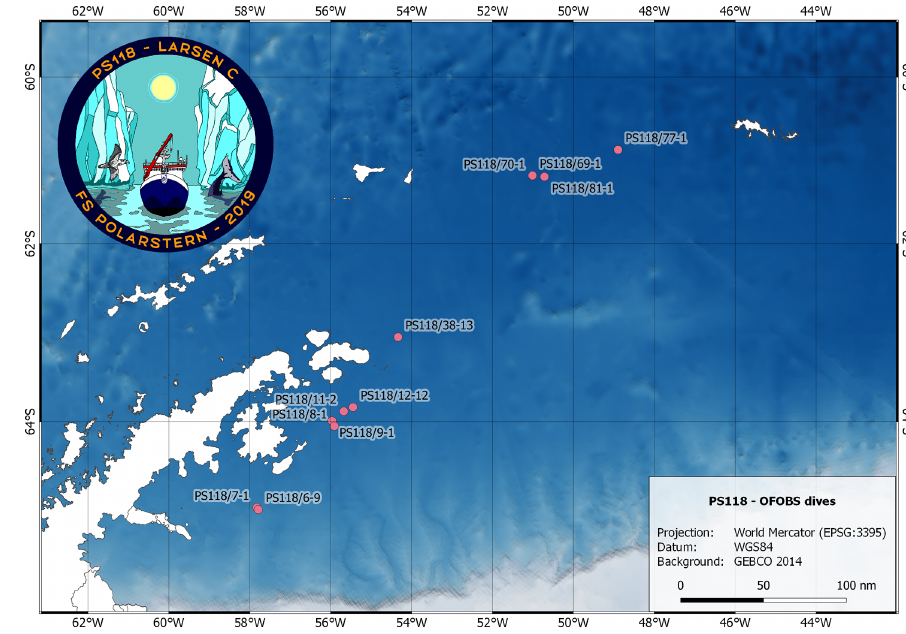
Figure 2. Regional map showing the positions of OFOBS deployments made during RV Polarstern cruise PS118. Table 1. Locations of OFOBS deployments during PS118. Start and end position coordinates and times are given, in addition to the numbers of timer and hotkey images collected during each